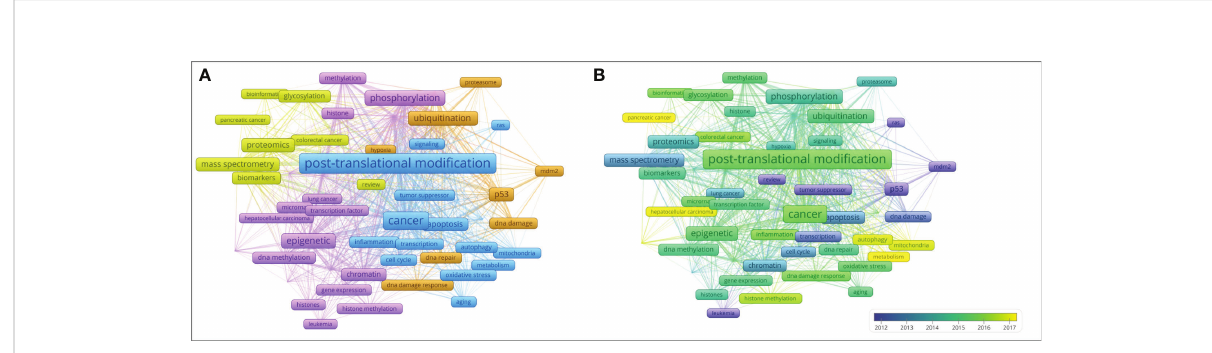
FIGURE 8 Keyword cluster plot and sequence diagram. Source: authors with VOSviewer. (A) Keyword cluster plot generated by VOSviewer. Each color represents a cluster, and clustering is composed of keywords or terms with high co-occurrence frequency. Each node represents a keyword. The higher the frequency, the larger the font. The attachment in the graph represents the connection of two keywords at least once in the literature; the higher the frequency of the keywords, the thicker the line. (B) Keyword sequence diagram. The color of the keyword corresponds to the time on the lower right. The closer the color is to yellow, the closer the popular time of the keyword is to the